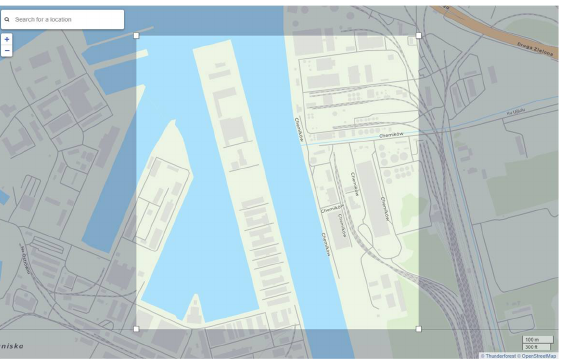
Figure 10. Virtual model of the Kashubian Canal. The last stage of creating the three-dimensional model was exporting the file to the Standard for the Exchange of Product Model Data (STEP), which complies with the ISO 10303 standard. The model prepared in this way was ready to be implemented in the CFD simulation program. In the event that it is necessary to have very detailed models of objects, the Numerical Model of Terrain Coverage from state resources can be used. The downloaded data in ASCII XYZ GRID formats can be converted, e.g., in the Cyclone 3DR application to obtain object models for analysis (Figure 11).